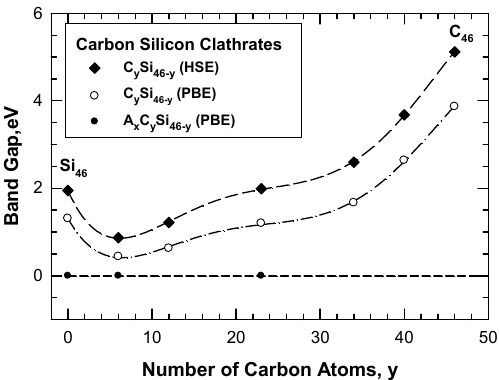
Figure 12. Computed band gap of C y Si 46-y as a function of the number of C atoms on the hybrid carbon–silicon framework. The band gap is at a minimum at about C = 6. The dashed line indicates the absence of a band gap and a metal-like conductor at zero band gap. From Chan and Peng [24]. Reprinted with permission from Springer.